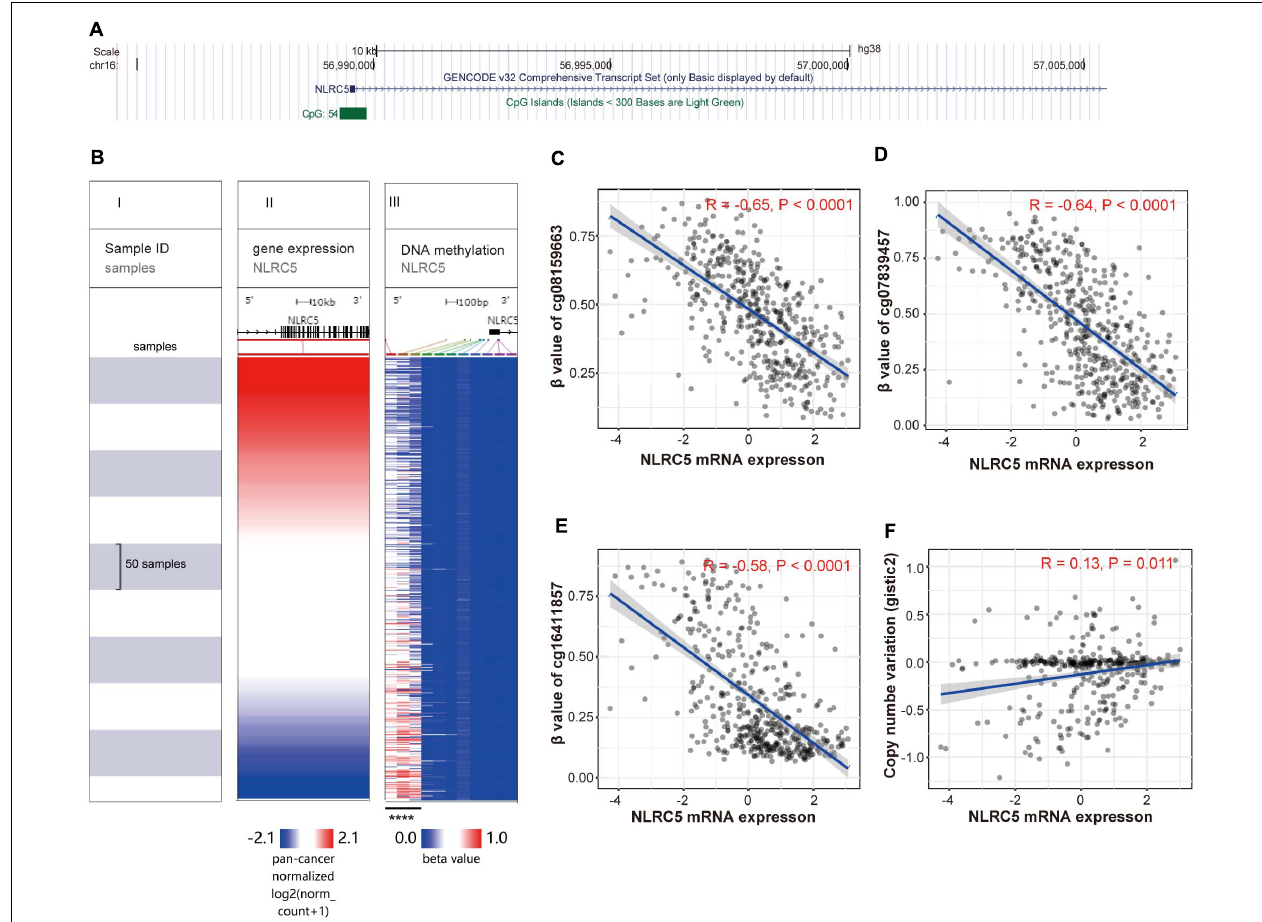
FIGURE 4 | NLRC5 expression correlates with the methylation status of the promoter and copy number variation (CNV). (A) A schematic representing the location of NLRC5 in the genome from the UCSC website. (B) The heatmap shows the NLRC5 expression and DNA-methylation β value of 11 CpG sites in TCGA SKCM. All samples were ranked from top to bottom according to the NLRC5 expression. Each row is the same sample. (I) samples; (II) NLRC5 expression; (III) β value (methylation level) of each CpG site in the promoter of NLRC5. Blue: low expression/methylation level; Red: high expression/methylation level. The β value of the first three methylation sites negatively correlated with NLRC5 expression (**** p < 0.0001). (C–E) Spearman correlation analysis of NLRC5 expression with β value of first three methylation sites, including cg08159663, cg07839457, and cg16411857 in TCGA SKCM, respectively. (F) Spearman correlation analysis of NLRC5 Copy Number Variation (CNV) with its mRNA expression in TCGA SKCM. Spearman r and p -value for each correlation are